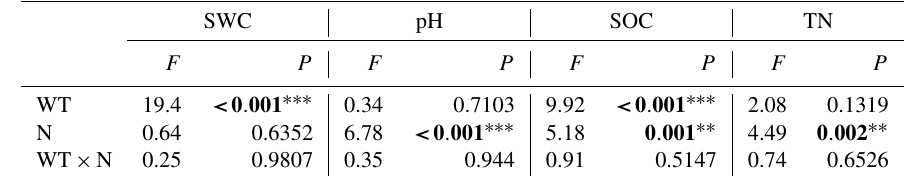
Table 2. Effects of water table (WT) and nitrogen (N) deposition levels and their interactions on soil properties using generalized least square (GLS)